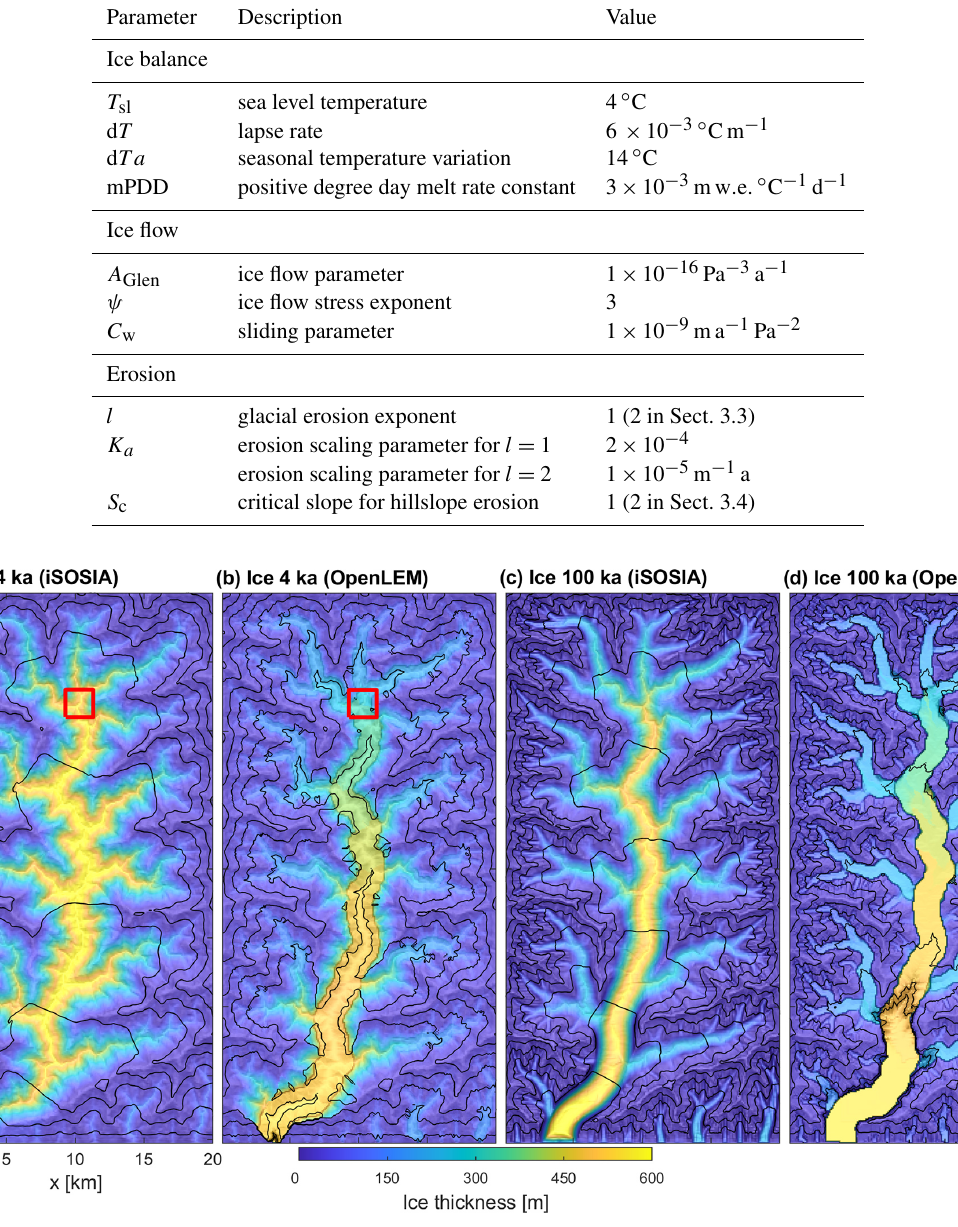
Figure 2. Differences in ice configuration in the numerical experiments with a constant ice production rate of 0.1ma − 1 . (a, b) Ice thickness after 4ka and (c, d) after 100ka for iSOSIA and OpenLEM ( δ = 0 . 25, a = 150m 0 . 4 ), respectively. Spacing of contour lines is 200m. The red square in (a) and (b) depicts the domain of